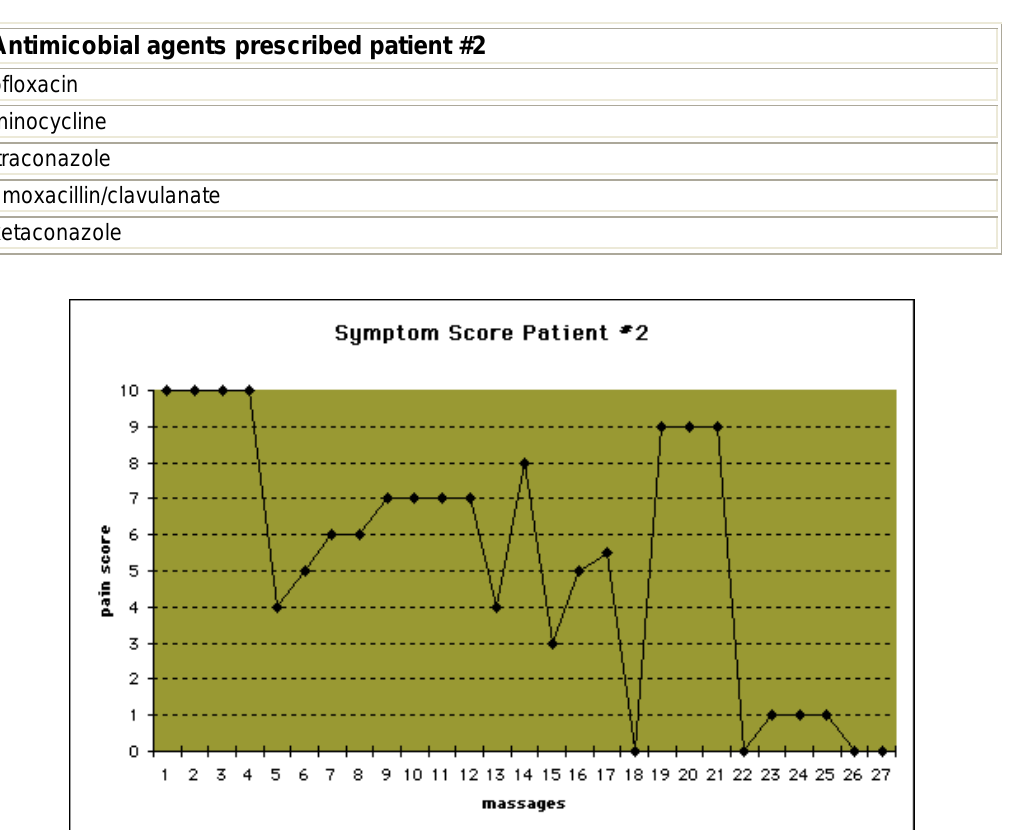
FIGURE 4. The dropping pain score of patient #2 over 27 prostatic